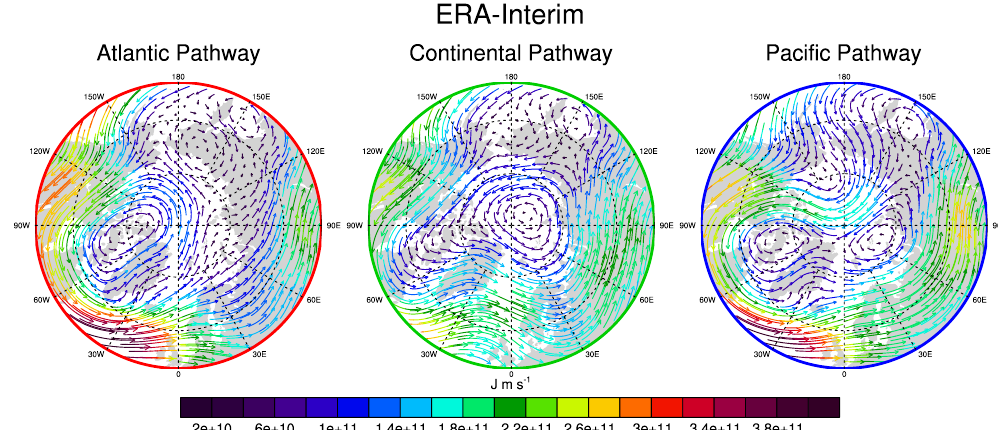
Figure 4. ERA Interim pathways modified from Figure 2 of Mewes and Jacobi